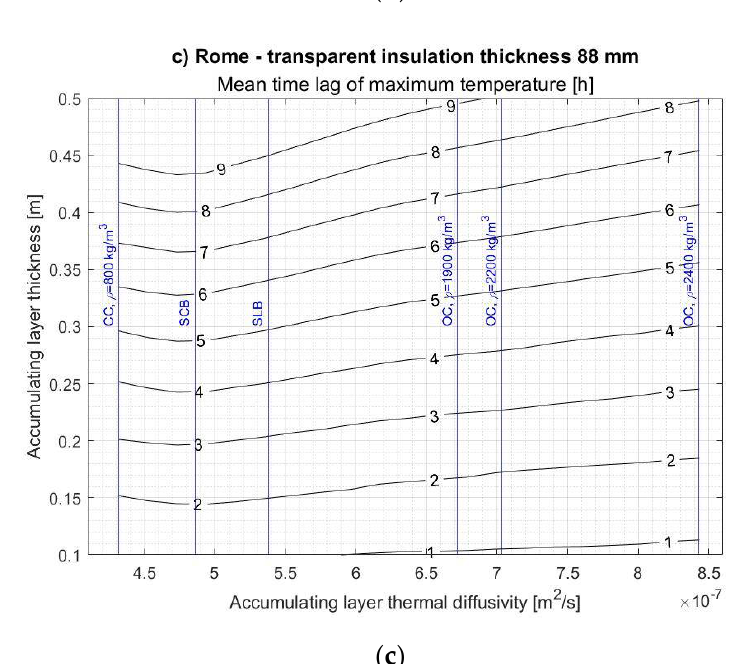
Figure A11. Cont